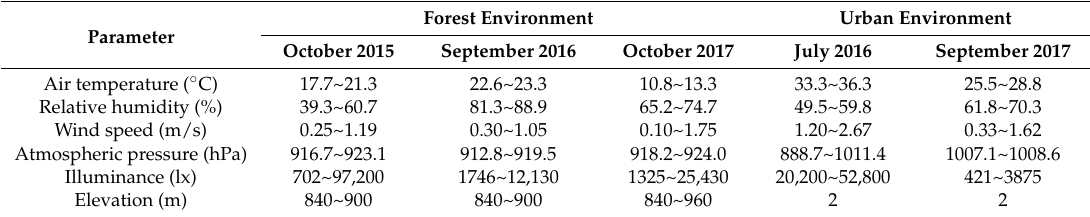
Table 1. Characteristics of the environment.